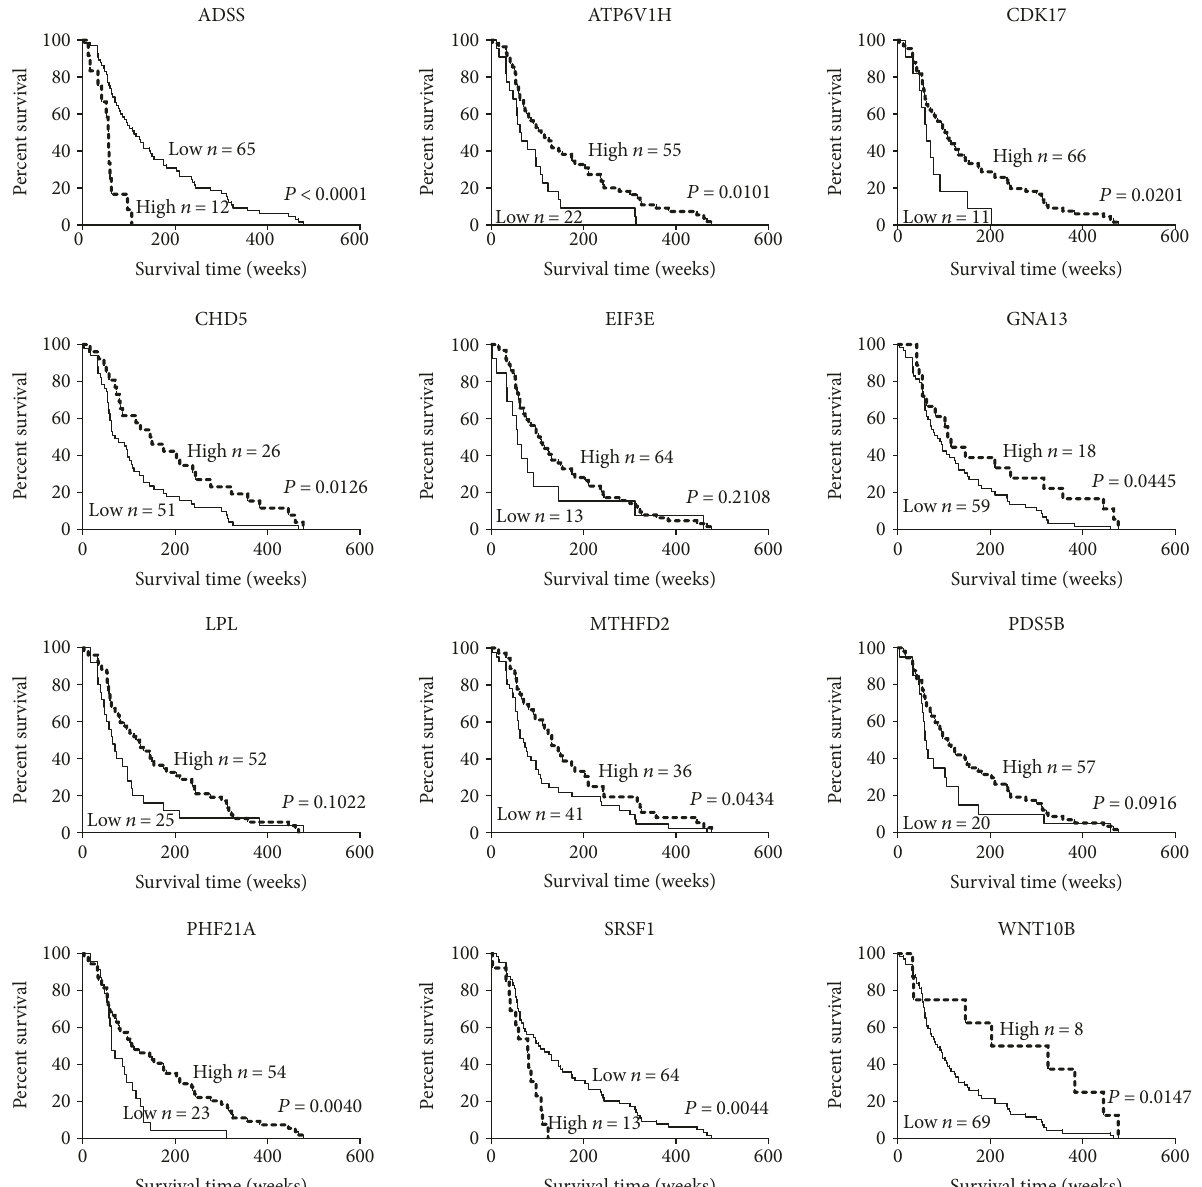
Figure 4: Kaplan-Meier analysis of overall survival for 12 hub genes in the validation dataset of 77 cases.